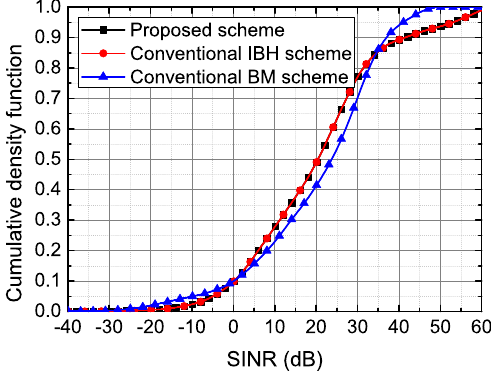
Figure 6. SINR results in relation to 3-schemes in single-gNB environment.